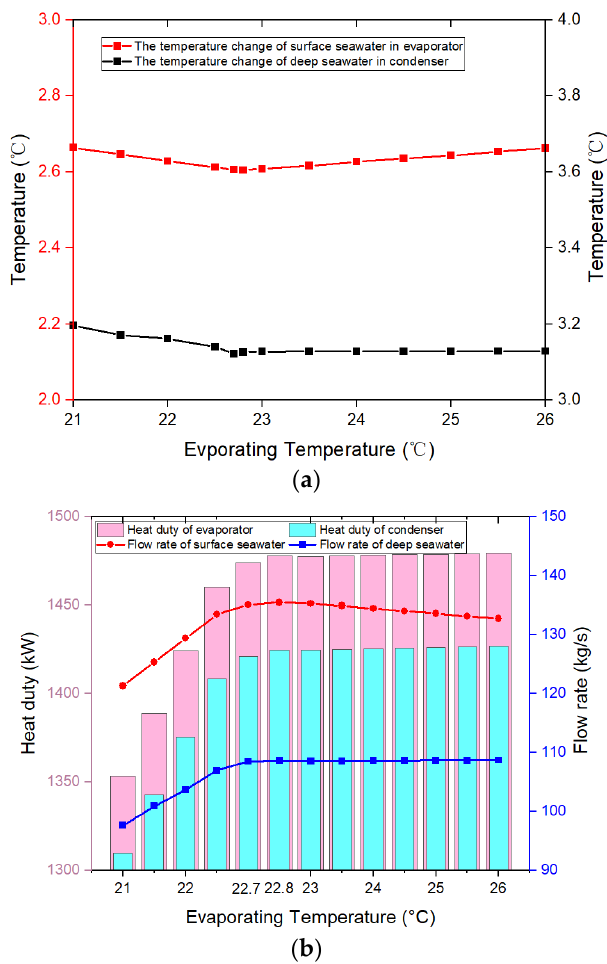
Figure 7. Analysis results for the surface seawater and deep seawater. ( a ) The temperature changes between the inlet and outlet of the evaporator/condenser for the surface seawater and deep seawater. ( b ) The heat duty of the evaporator/condenser and the flow rate of the surface/deep seawater.